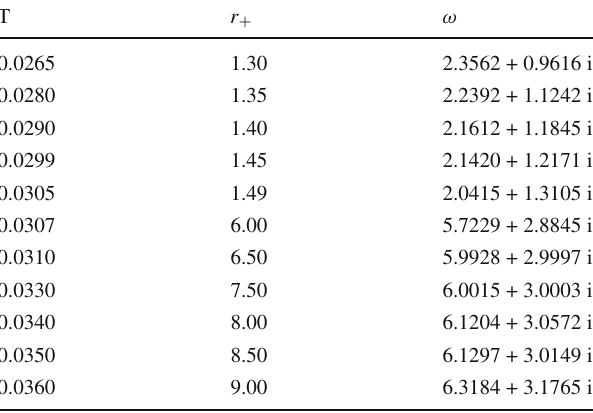
Table 2 The QNM frequencies of massless scalar perturbations for l = 0 and P = 0 .